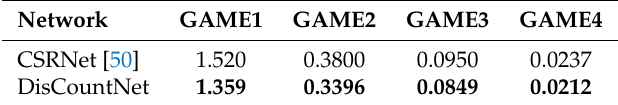
Table 2. Comparison of GAME [6] metric results which shows both counting and localization errors.